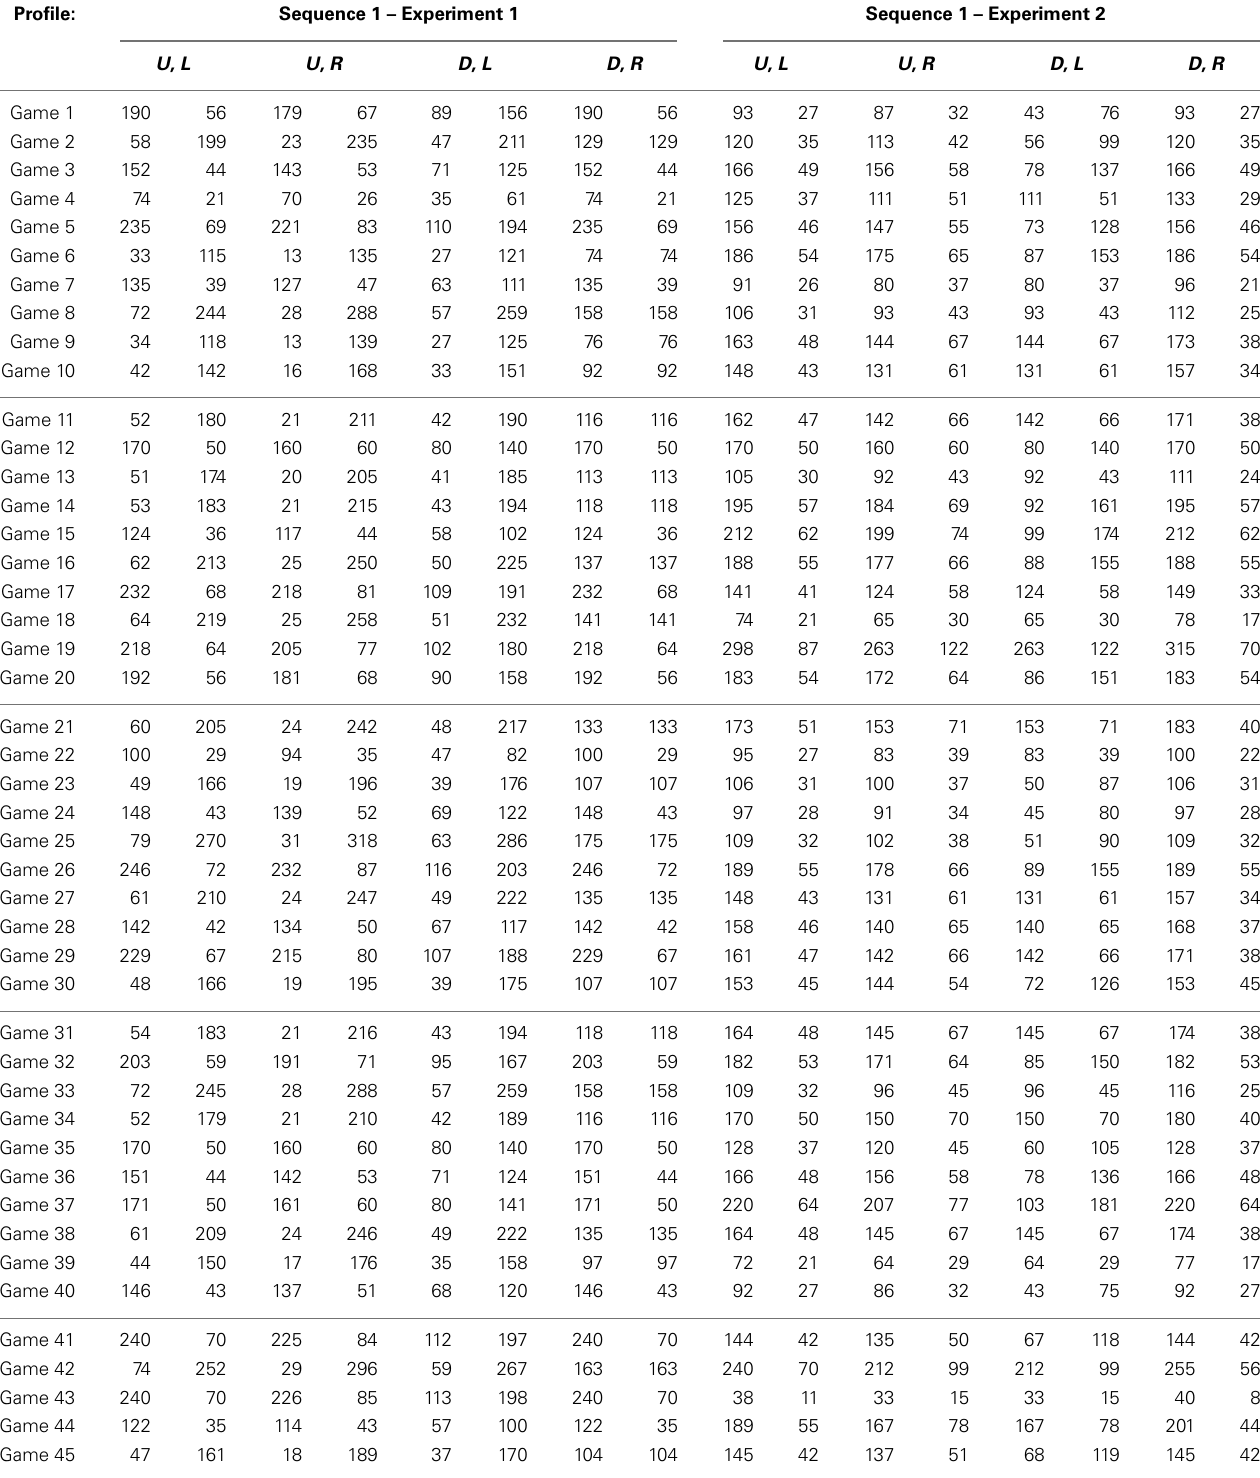
TableA3 |Two of the game sequences played in Experiment 1 and